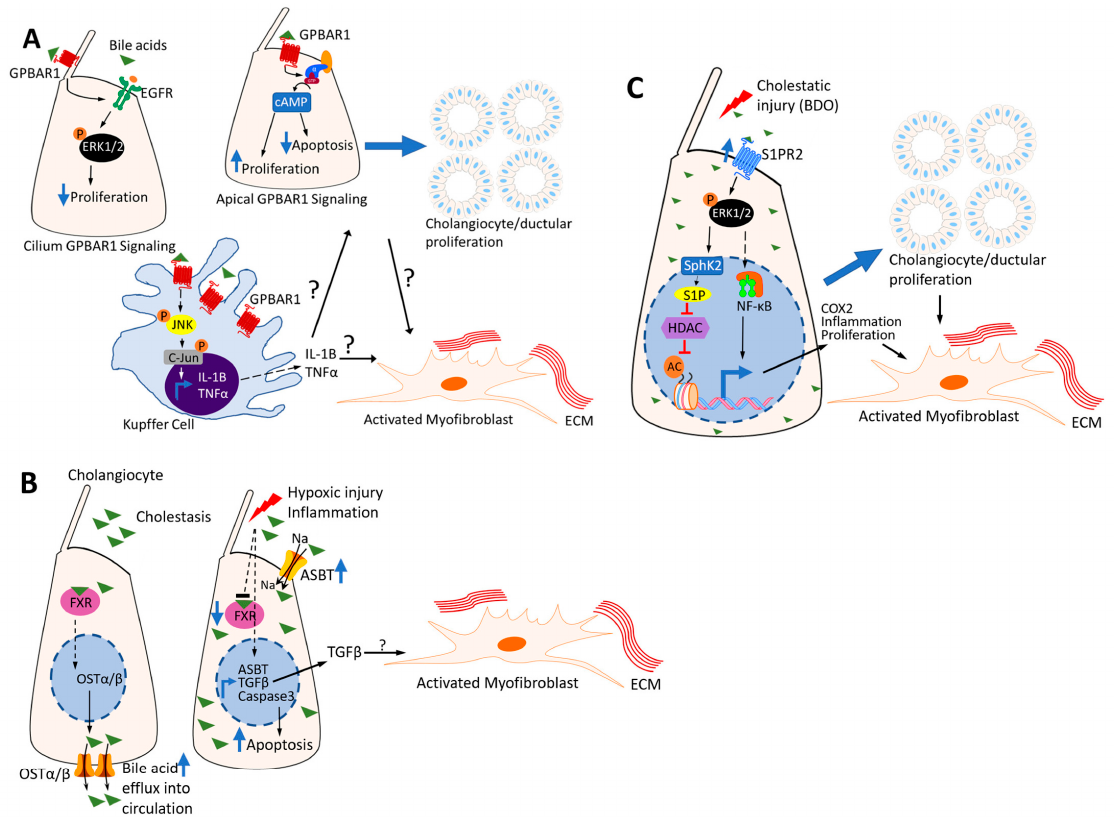
Figure 2. The role of bile acid receptors in biliary fibrosis. ( A ) Bile acid activation of GPBAR1 (TGR5) in the cilium compartment suppresses proliferation but activation of apical GPBAR1 promotes proliferation in cholangiocytes. In Kuppfer cells, GPBAR1 (TGR5) activation stimulates expression of inflammatory cytokines, which may activate myofibroblasts. ( B ) FXR increases the expression of OST α / β to facilitate the efflux of bile acids under cholestatic conditions. With hypoxic injury or overwhelming inflammation, FXR expression/activation is decreased with increased expression of ASBT, apoptotic machinery and TGF β , which may activate myofibroblasts. ( C ) S1PR2 expression is increased with cholestatic injury. Bile acid activation of S1PR2 activates ERK1/2 signaling, which promotes sphingosine kinase 2 (SphK2) ‐ mediated sphingosine 1 ‐ phosphate levels (S1P). S1P promotes gene expression by inhibiting histone deacetylases (HDACs). ERK1/2 also promotes inflammation and proliferation in part through NF ‐κ B signaling.